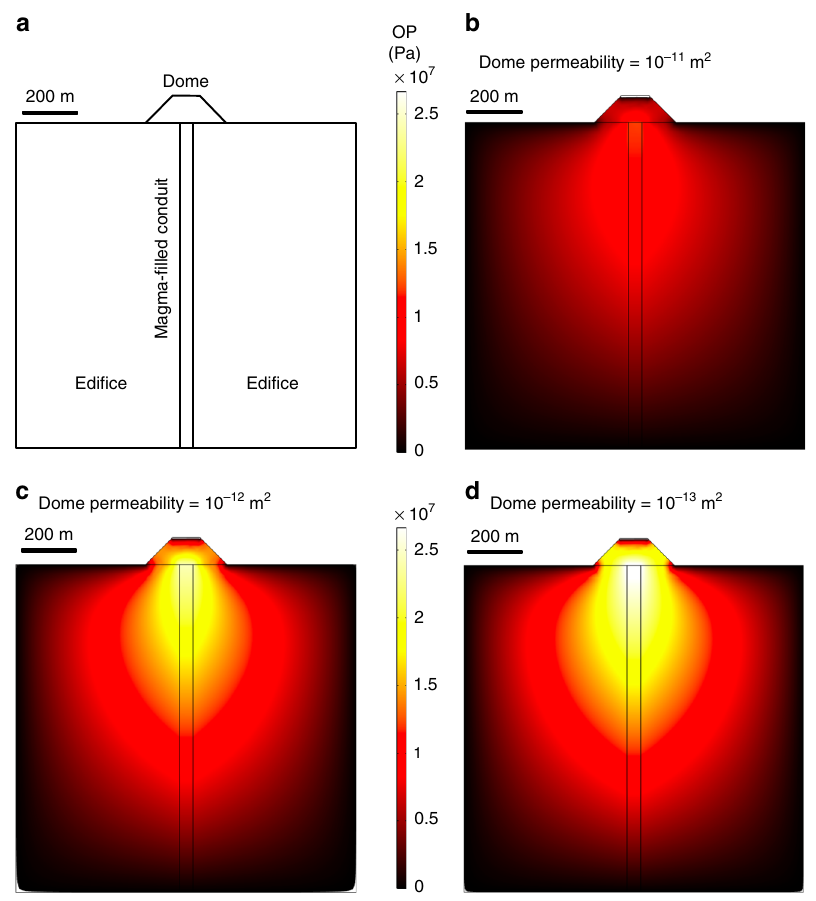
Fig. 3 Pore pressure augmentation within and beneath a lava dome. a Model setup. b – d Numerical models showing the magnitude and distribution of pore overpressure (white and yellow represent high overpressure and red and dark red represent low overpressure) for domes with different equivalent permeabilities (ranging from 10 − 11 to 10 − 13 m 2 ). The models in panels b , c , and d are designed to represent an unaltered, moderately altered, and highly altered dome, respectively. OP